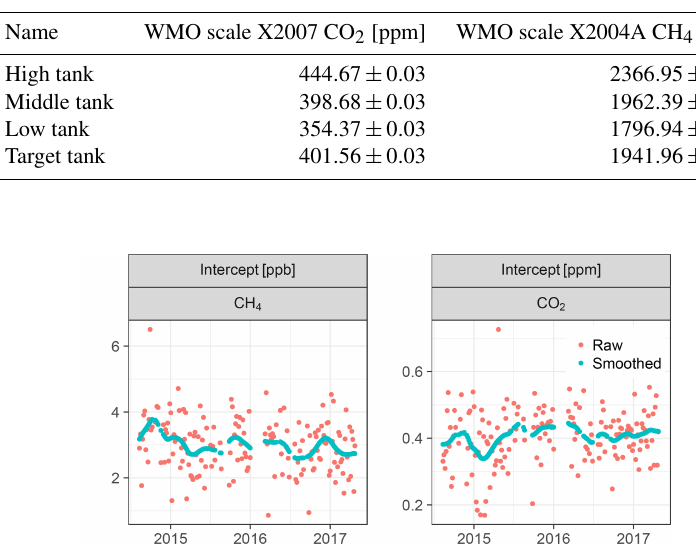
Table C1. Calibrated dry air mole fractions of the air tanks in use at Ambarchik over the period covered in this paper. For a discussion of the uncertainties, see Appendix E2.